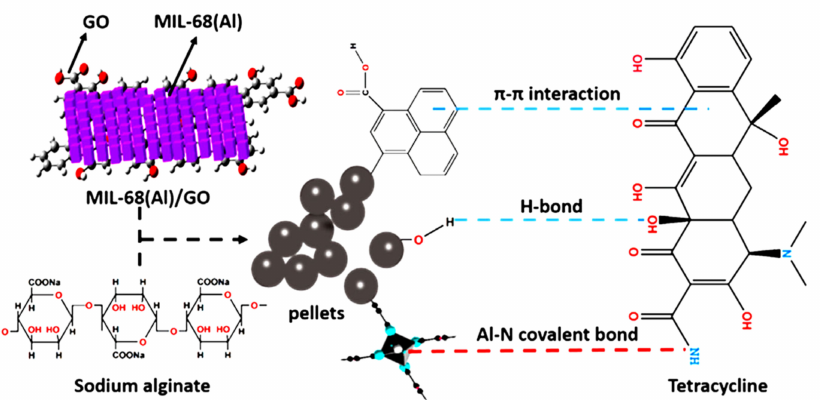
Figure 14. Adsorption mechanisms of TC on MIL-68(Al)-GO. Reprinted with permission from